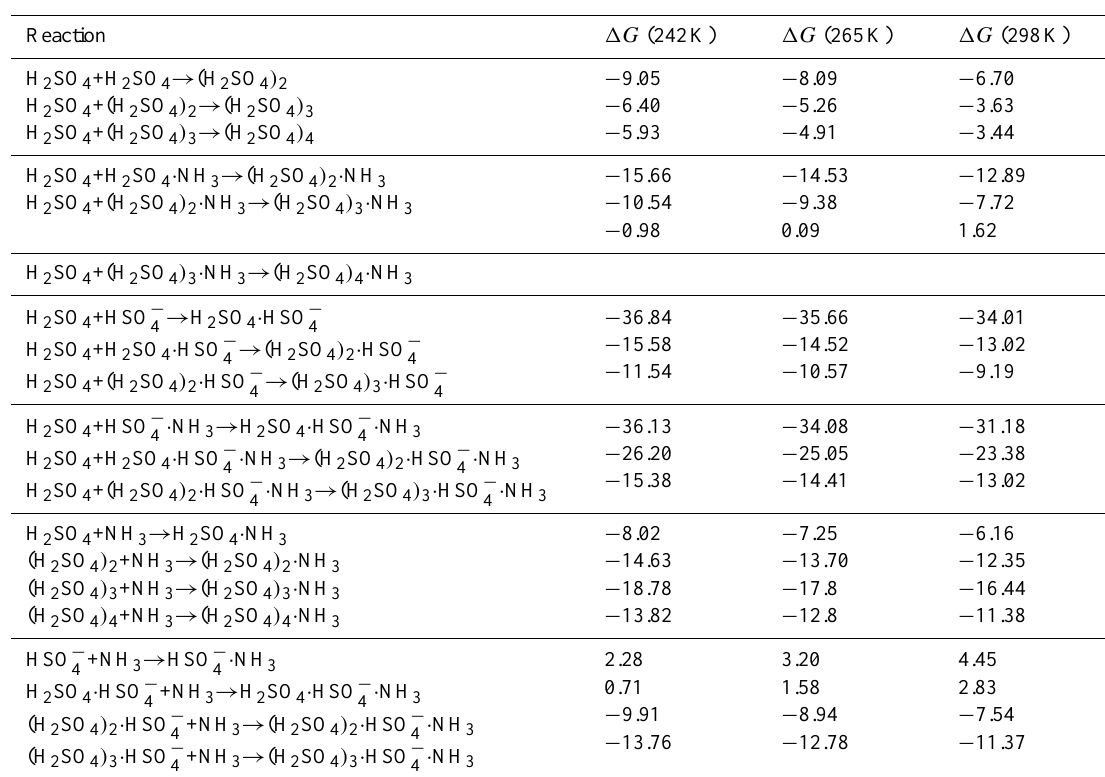
Table 5. Free energies for the addition of one sulfuric acid molecule and one ammonia molecule to various clusters at different temperatures and 1 atm reference